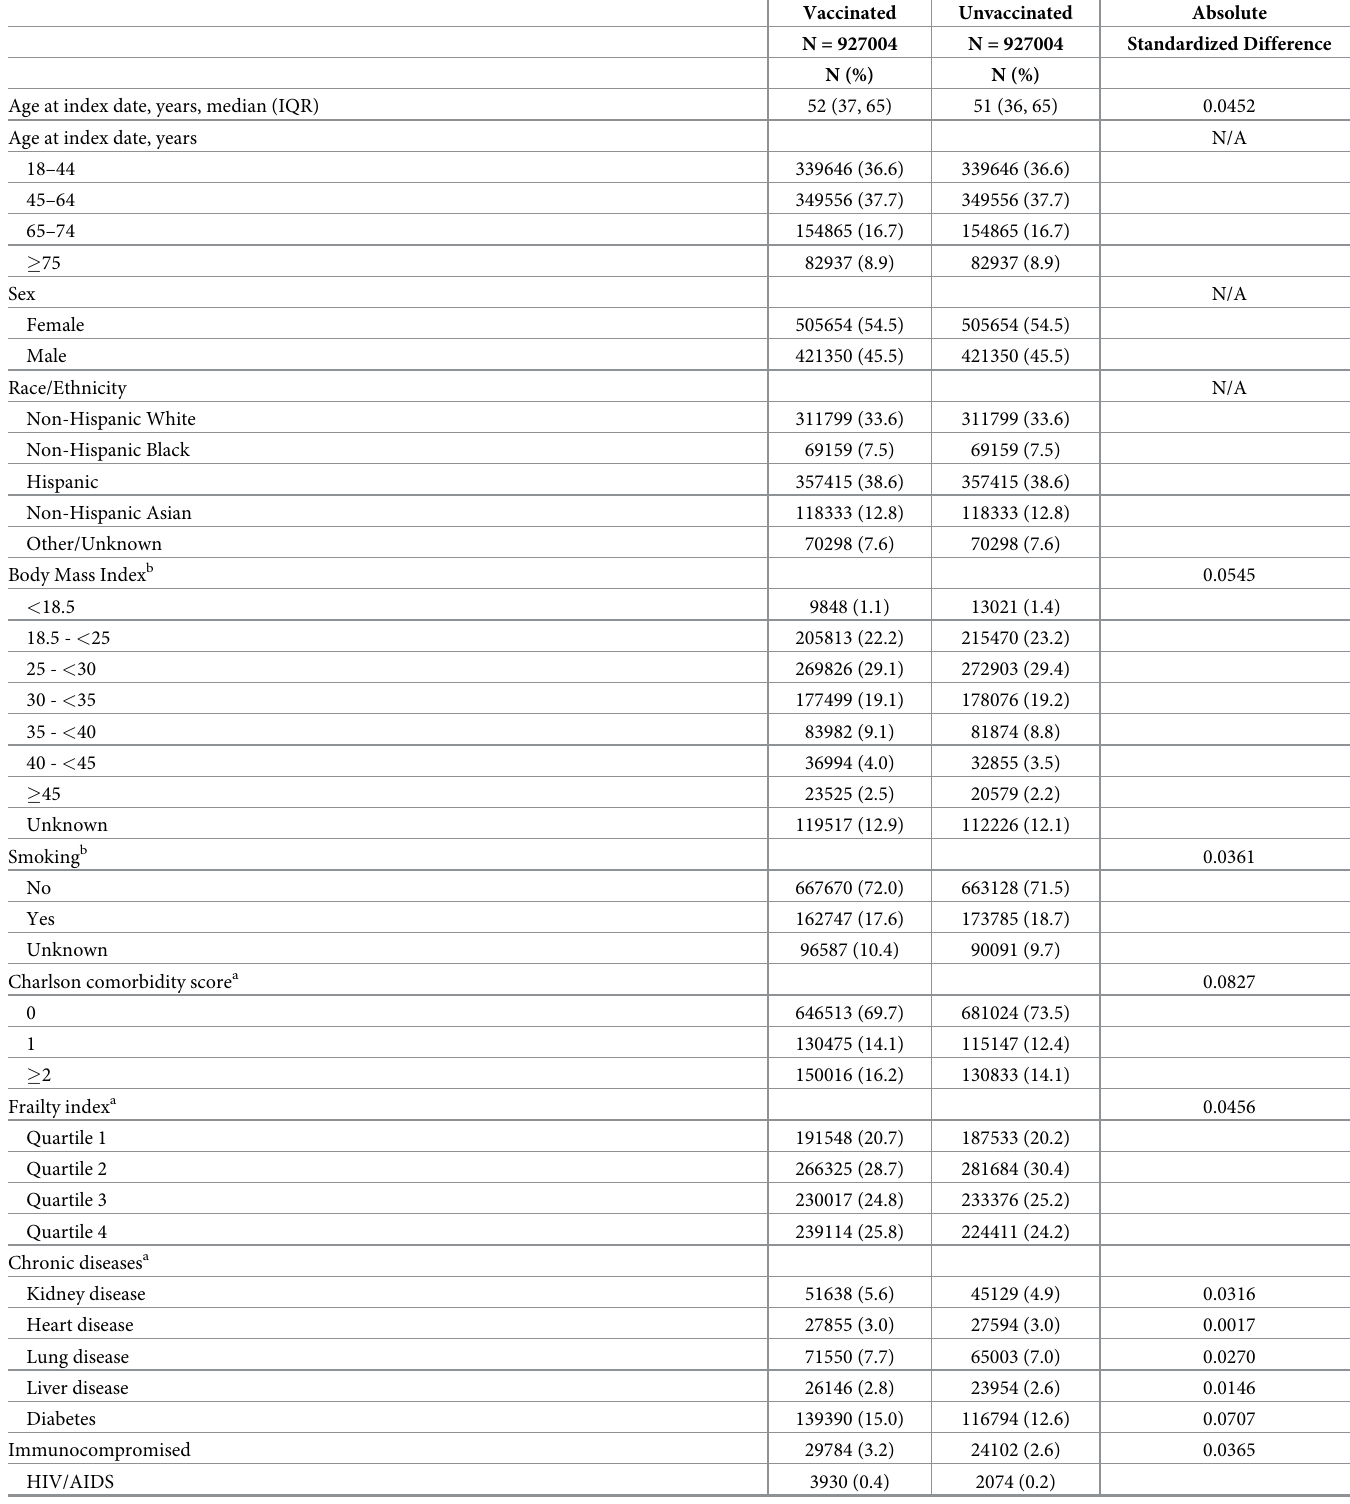
Table 1. Baseline characteristics of 2-dose mRNA-1273 vaccinated and unvaccinated